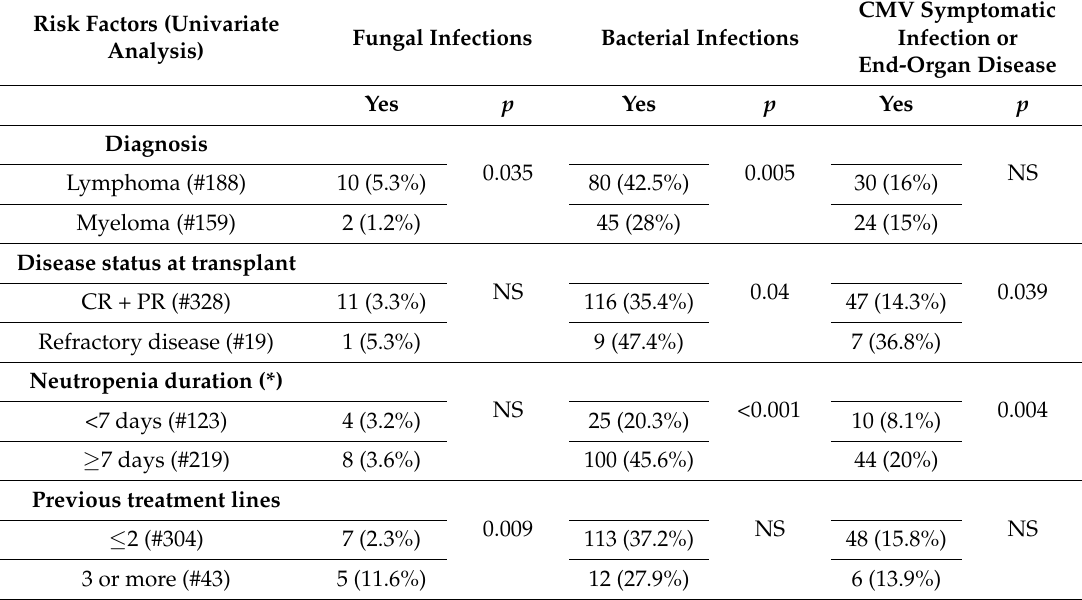
Table 4. Risk factors for CMV, fungal and bacterial infection in our study cohort of 347 patients. Risk Factors